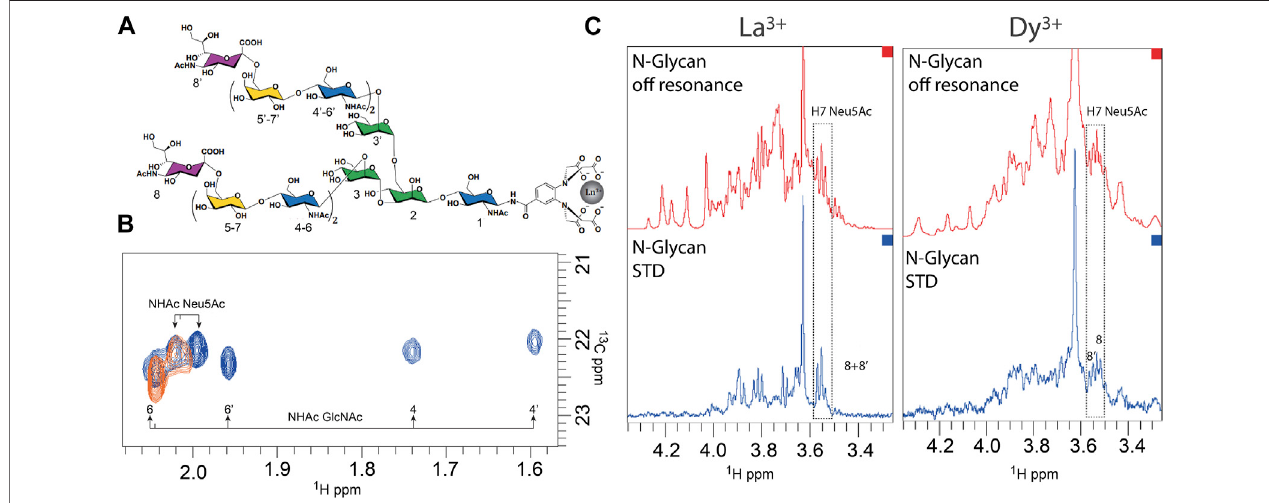
FIGURE 4 | Recognition of a complex N -glycan by the hemagglutinin from HK/68 H3N2 in fl uenza virus deciphered by NMR (Fernández de Toro et al., 2018). (A) . Structureofthe N -glycanwiththecorrespondingnumberingofthe14monosaccharides. (B) .Superimpositionof 1 H – 13 CHSQCspectraintheregionoftheNHAcmethyl groupofGlcNAcand Neu5Acofthe N -glycanloadedwithLa 3+ (diamagnetic,inorange)and withDy 3+ (paramagnetic,inblue). (C) .STD – NMRexperimentof N -glycanin the presence of La 3+ (diamagnetic conditions, left) and loaded with Dy 3+ (paramagnetic conditions, right). Adapted from Canales et al. (2017).